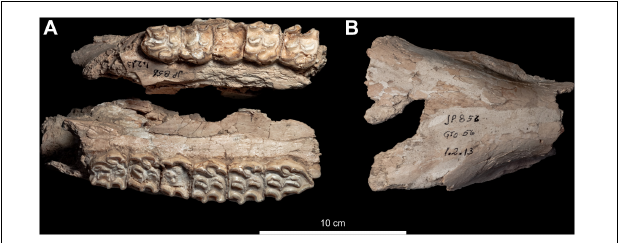
FIGURE 8 | (A) Left and right maxillaries, notice the teeth without hypocone. (B) Nasal bone with shallow DPOF, and smooth borders. The three bones belongs to the same